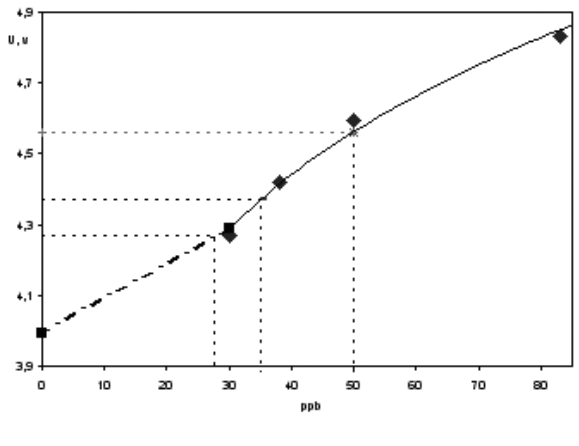
Figure. 1 Ozone concentration dependence of sensor signal (Calibration curve).